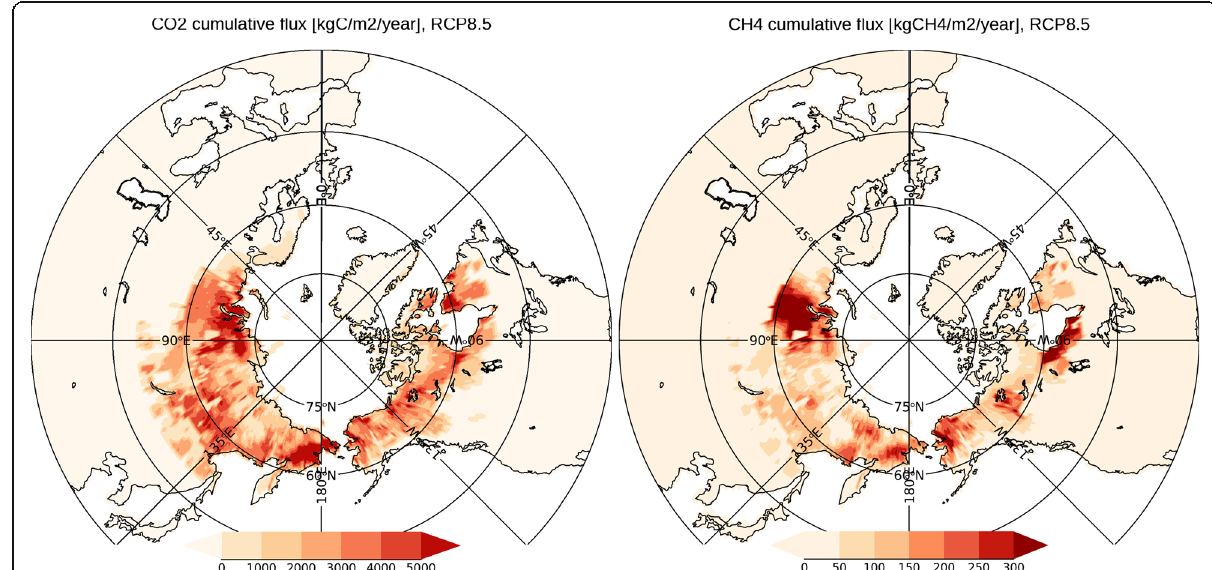
Fig. 5 The cumulative CO 2 flux [TgC] (bottom, left) and CH 4 flux [TgCH4] (bottom, right) due to the permafrost degradation (dynamic + thermodynamic) at the end of the twenty-first century in the RCP8.5 scenario. The average of all ensemble members is